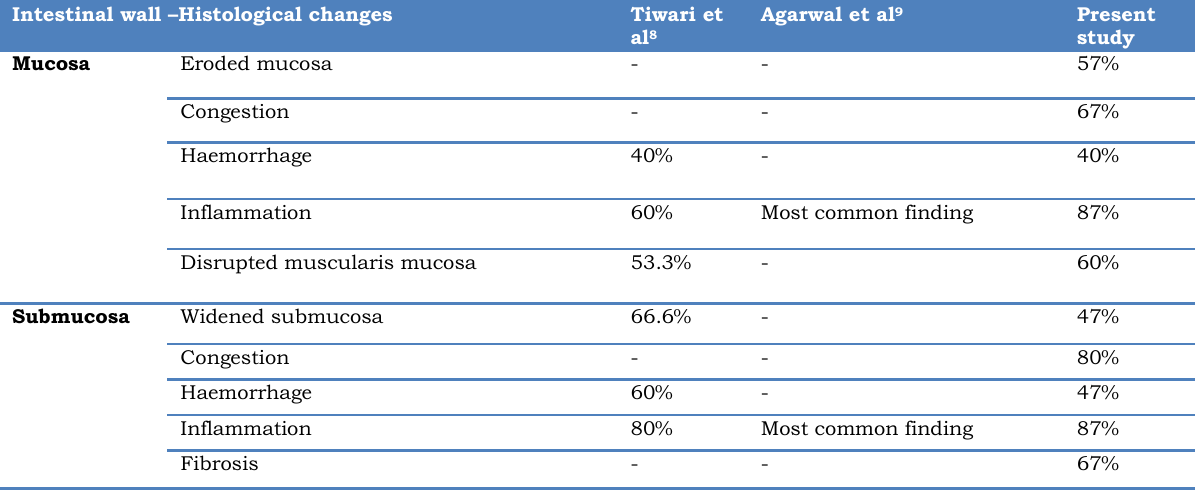
Table 3: Comparison of histological changes in bowel wall of ARM with other studies Intestinal wall – Histological